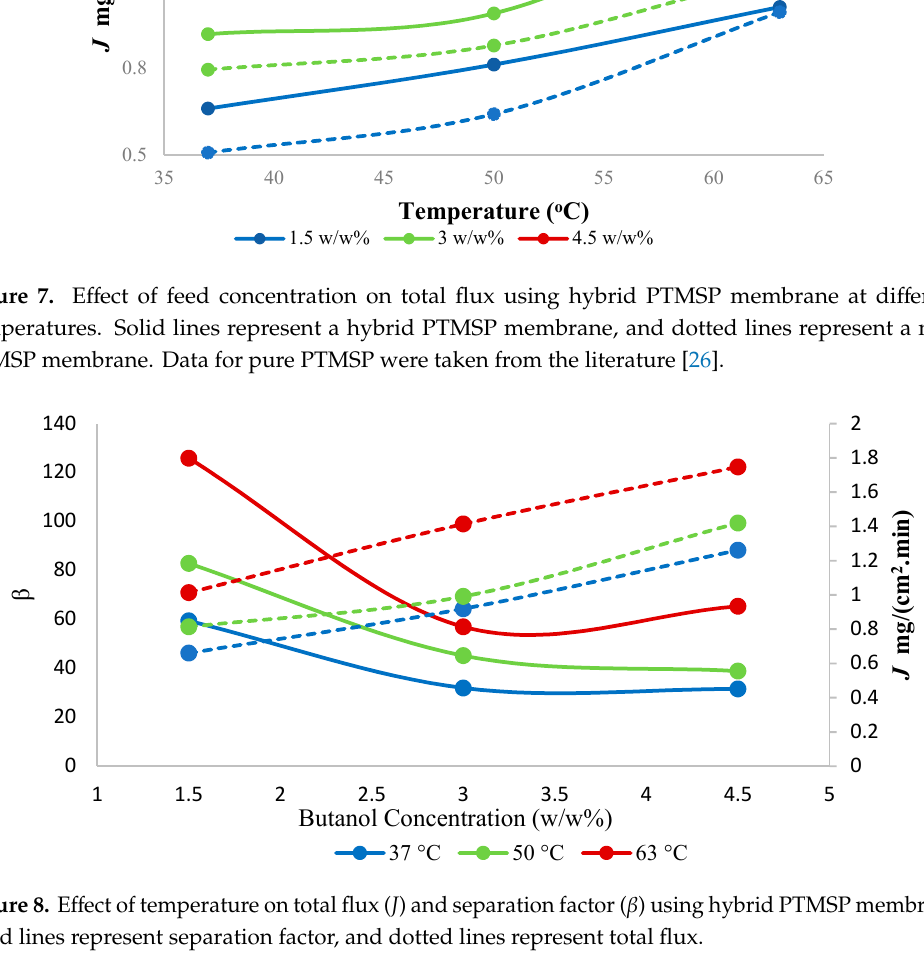
Figure 9. Effect of feed concentration on selectivity ( α ) against temperature. Solid lines represent hybrid PTMSP membrane and dotted lines represent a neat PTMSP membrane. Data for pure PTMSP were taken from the literature [26]. The permeability of both 1-butanol and water dropped noticeably with increasing temperature and increased with increasing concentration of 1-butanol in the feed (Figure 10). Negative activation energies were observed for the permeability of water and 1-butanol in both hybrid and neat membranes (Supplementary materials, Figure S2, S3, and S4), which is consistent with the literature [36]. As we show below, the activation energy of 1-butanol diffusion was positive. Hence, this evidences the exothermic dissolution of 1-butanol in PTMSP and in the hybrid SNPs-PTMSP, while the exothermic dissolution of water in these materials can be expected. When compared to the neat PTMSP membrane, the hybrid membrane showed an increase in the permeability of 1-butanol and water by 10% and 18%, respectively. The earlier reported results for the neat PTMSP membrane [26] showed, on average, 6% higher selectivity compared to the present hybrid membrane. The hybrid membrane appears, however, more selective in the case of diluted feeds (Figure 9). Similar results were observed with silica-filled PTMSP membranes, which showed permeate flux increases, but selectivity ethanol/water remains unchanged [23].